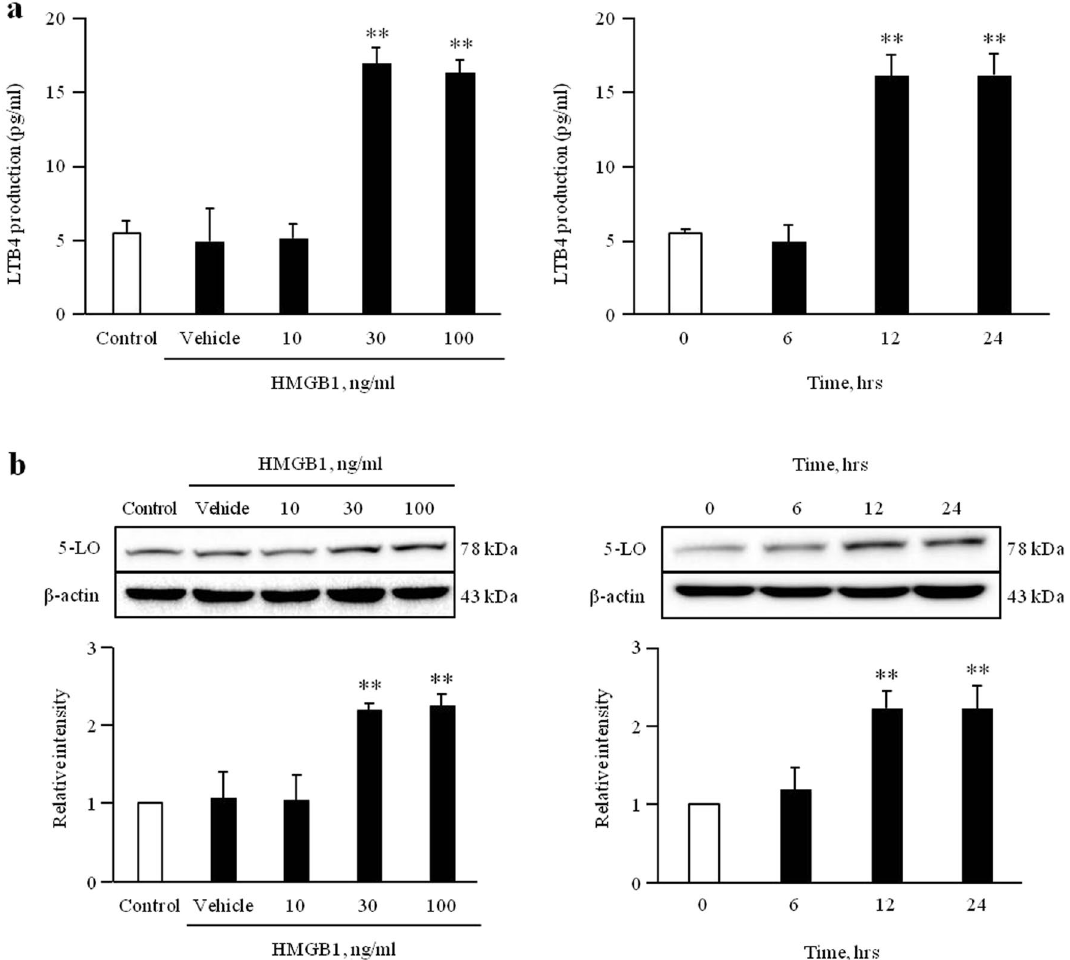
Figure 2. Role of HMGB1 on 5-LO activity and expression in VSMCs. VSMCs were treated with HMGB1 (0 to 100 ng/ml) for 12 h or HMGB1 (30 ng/ml) for 0 to 24 h. ( a ) LTB4 production was measured in the cell culture media, and results were expressed as the mean ± SEM of 3 independent experiments. ** p < 0.01 vs. corresponding value in control or 0 h. ( b ) The 5-LO expression levels were determined by Western blotting. β-actin was used as an internal control. Relative intensities were expressed as the means ± SEMs of 4–5 independent experiments. ** p < 0.01 vs. corresponding value in control or 0 h. Image analysis was performed using the Amersham-Imager 680, ver. 2.0. software (https:// www. cytiv alife scien ces. com/). Signal was quantified with GraphPad Prism 5, ver. 5.01. software (https:// www. graph pad. com/). Cropped gels were displayed and full- length blots/gels are presented in supplementary Fig.